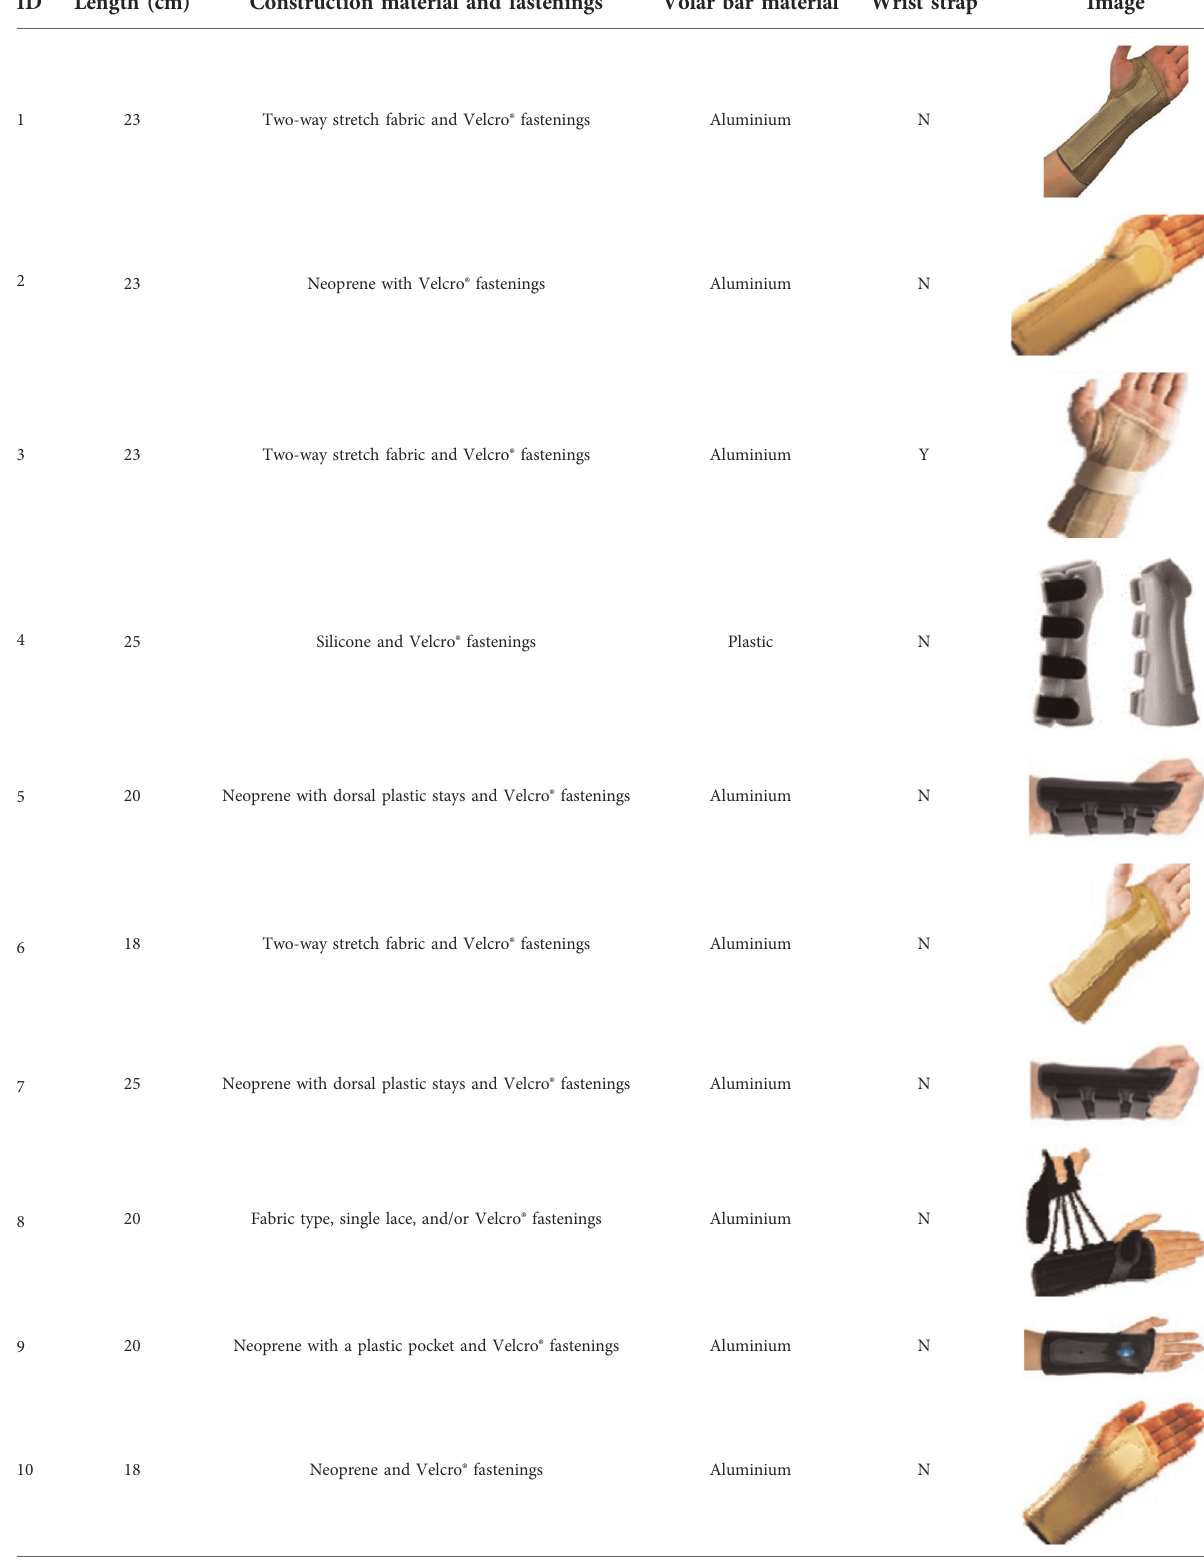
TABLE 1 Range of commercially available wrist-hand orthoses used in this study showing their length (in cm), construction material, fastenings, the type of volar bar, and the presence of an additional wrap around the wrist strap. a ID Length (cm) Construction material and fastenings Volar bar material Wrist strap